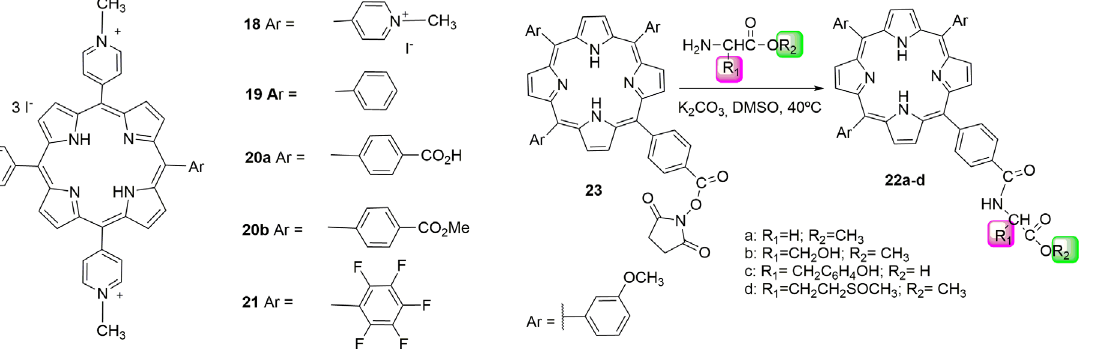
Figure 20 - Synthetic strategy to porphyrin amino acid conjugates 22a-d .